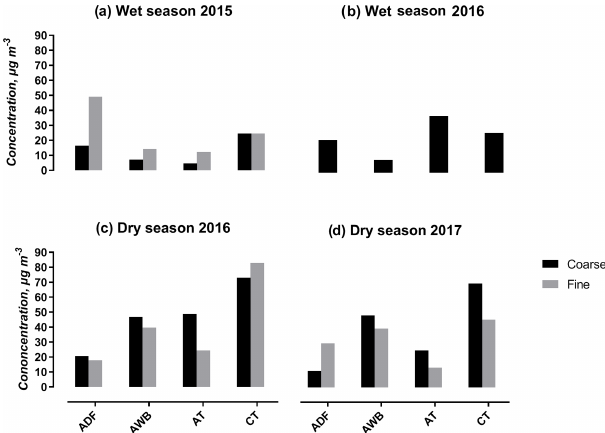
Figure 12. Dust concentrations at the different study sites for each campaign and for the different sizes (C in black, fine in light grey, ultrafine in